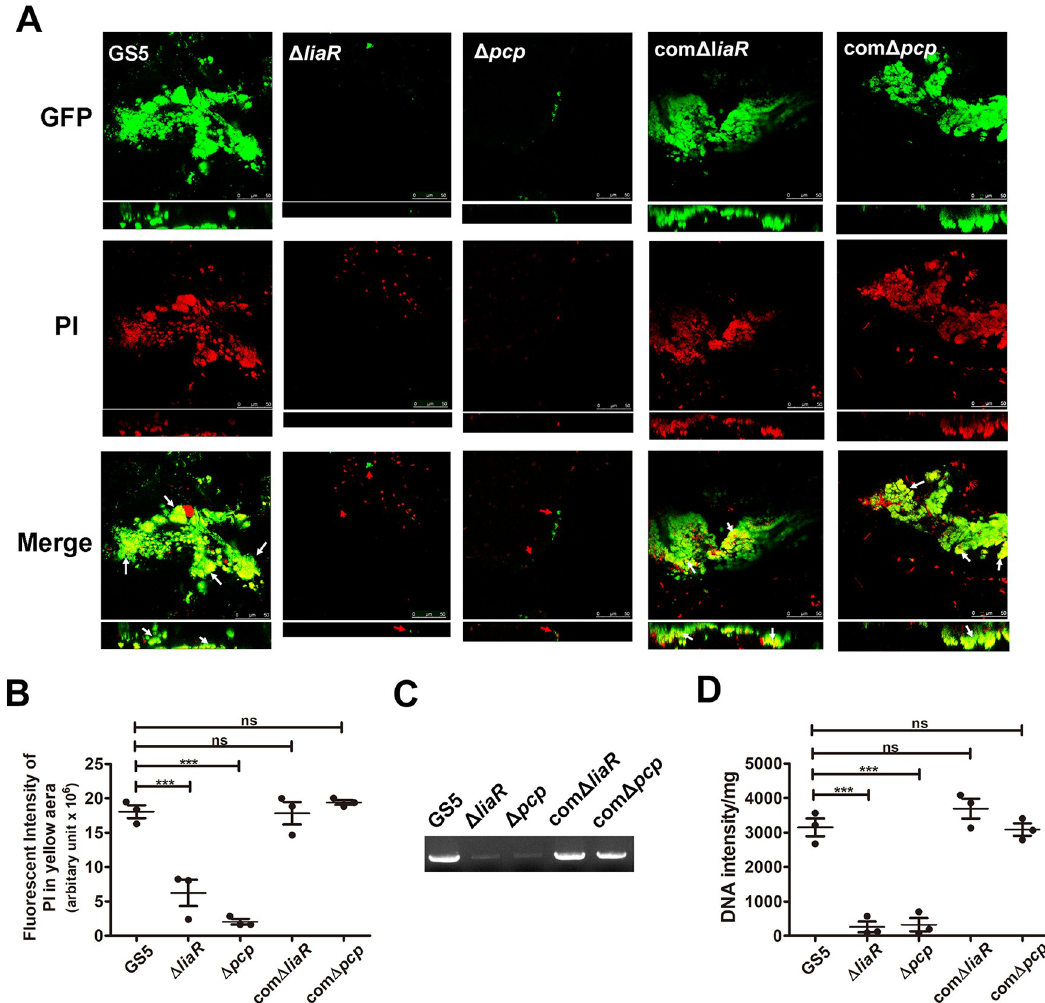
Fig 5. PCP mediates bacterial eDNA release contributing to S . mutans biofilm formation in vivo . (A) GFP-tagged S . mutans GS5 wild type, Δ liaR , Δ pcp , com Δ liaR , or com Δ pcp strains were intravenously injected into experimental IE rats, and the biofilm inside the vegetations harvested from injured heart valves were observed by CLSM (630 × magnification). The data represent the CLSM images of biofilm formation inside the vegetation. S . mutans were labeled with GFP (green), and bacterial eDNA was stained with 10 μ M propidium iodide. Yellow areas represent the presence of both S . mutans and eDNA (white arrows) and red arrows indicate single populations or aggregates without embedded eDNA. These experiments were replicated at least three times, with a representative experiment shown. (B) The fluorescence intensity of eDNA images using propidium iodide staining in the yellow aera was measured. The results show the quantified data of the extended focus images of biofilms using Image J software (National Institutes of Health). Scatter plots show values from individual rats, and each rat represents an independent experiment. Data are expressed as the means ± standard deviations. ��� P < 0.001 by 1-way analysis of variance. (C and D) Total DNA isolated from vegetation (without lysing bacteria) was PCR-amplified with bacterial 16S rRNA primers and products were resolved on 1% agarose gels (C) and quantified with Image J software (National Institutes of Health) (D). Scatter plots show values from individual rats, and each rat represents an independent experiment. Data are expressed as the means ± standard deviations; ��� P < 0.001 by 1-way analysis of variance. GFP, green fluorescent protein; IE, infective endocarditis; eDNA, extracellular deoxyribonucleic acid; and CLSM, confocal laser scanning microscopy; PI, propidium